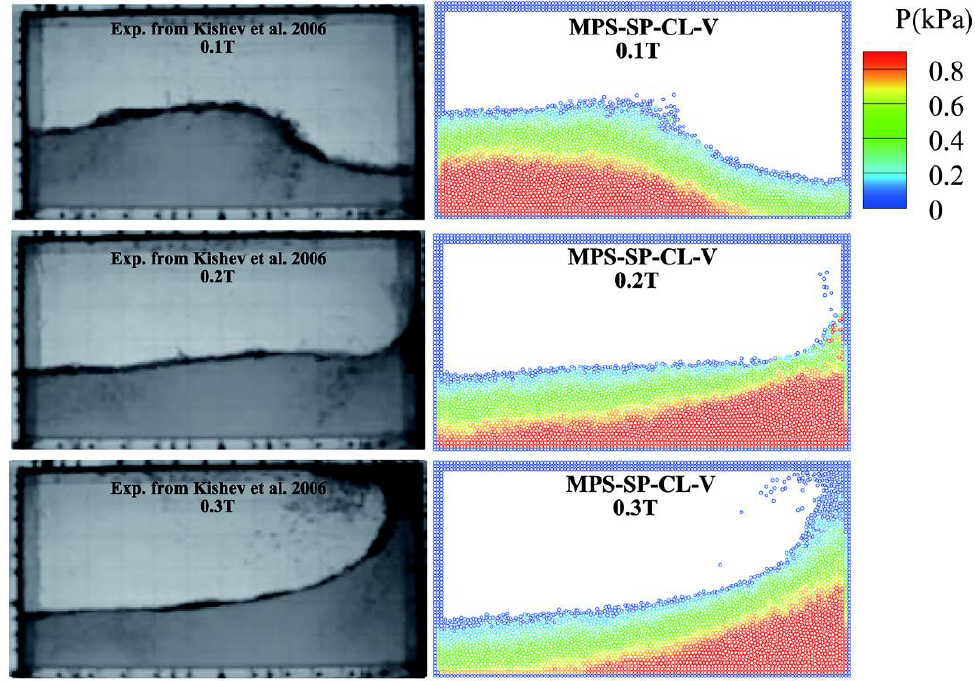
Figure 17. Comparison of free surface profiles of the MPS-SP-CL-V with the experimental results of Kishev et al. [44].